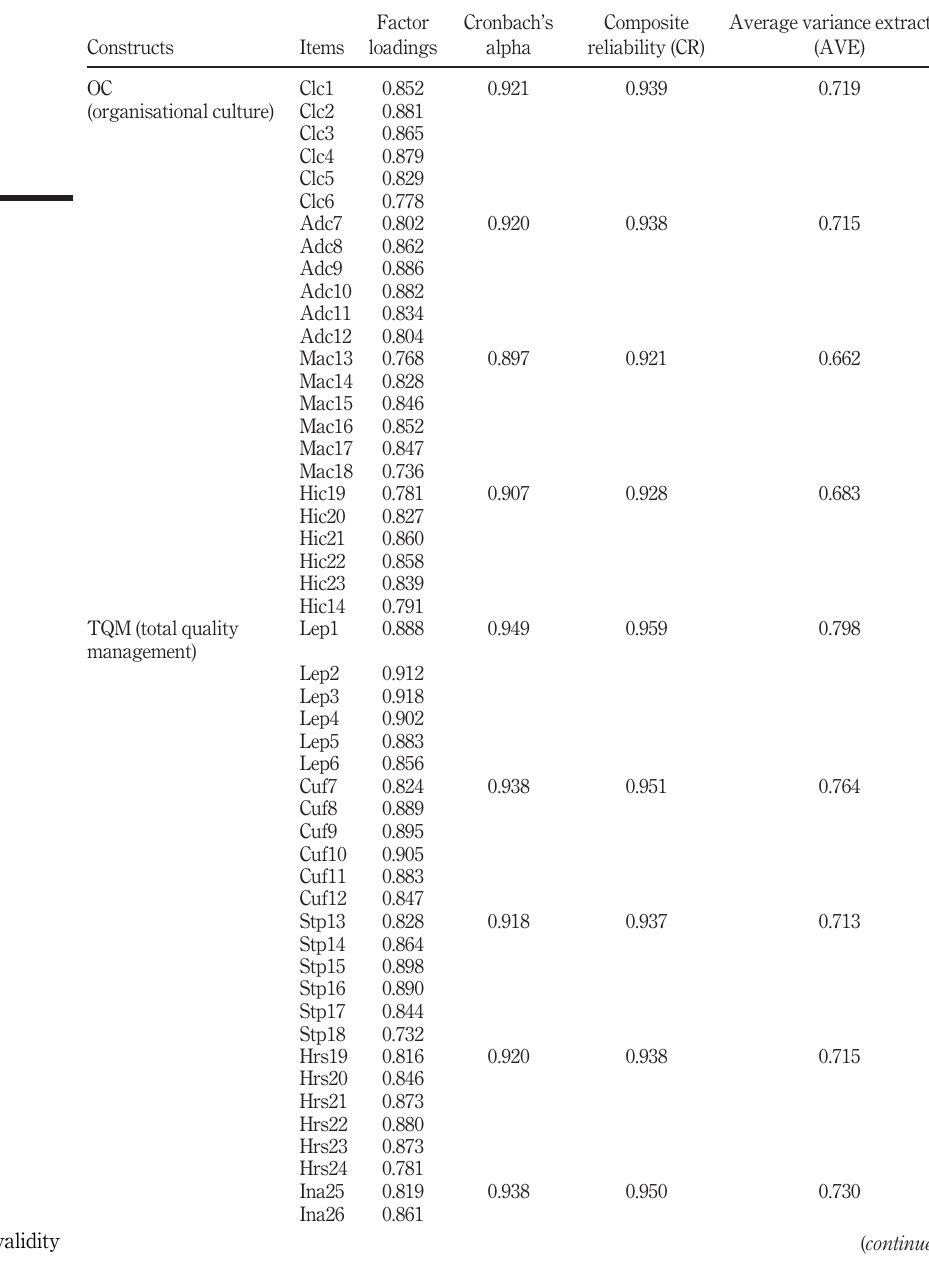
Table 1. Convergent